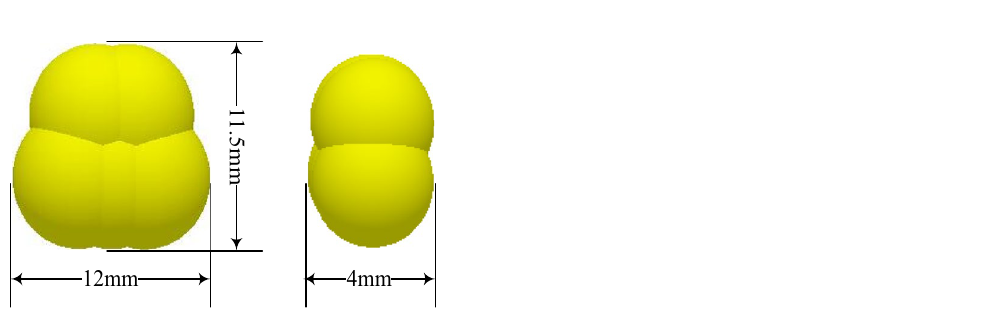
Figure 7. Simulation model and simulation process.